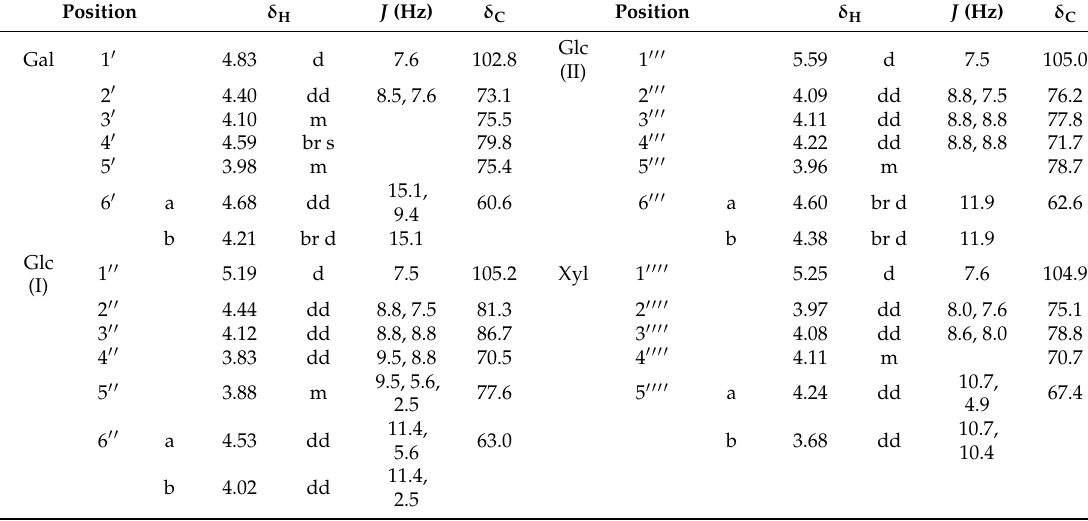
Table 1. 1 H and 13 C Nuclear magnetic resonance (NMR) spectral data for the sugar moiety of 4 in C 5 D 5